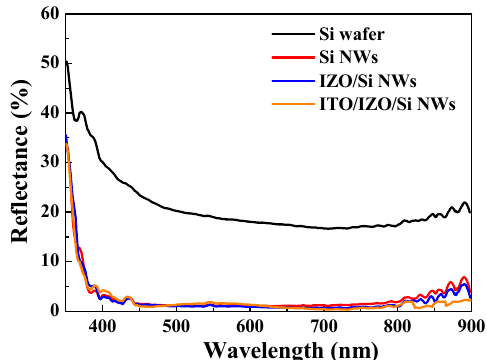
Figure7. Reflectance of the different structures: Si wafer, SiNWs, IZO/SiNWs, and ITO/IZO/SiNWs.